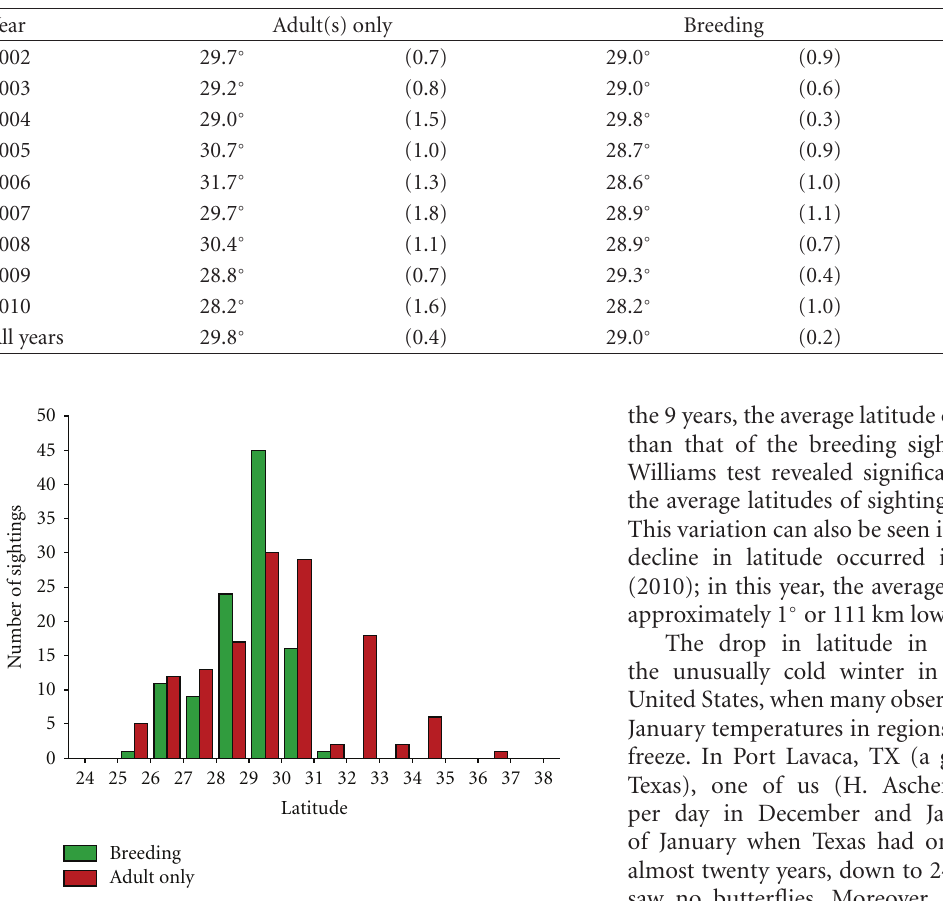
Table 2: Summary of average latitudes of monarch winter sightings across all years and sighting categories (adults only or confirmed breeding). Numbers in parentheses indicate 95% confidence intervals. Means and confidence intervals calculated using circular statistics [13].